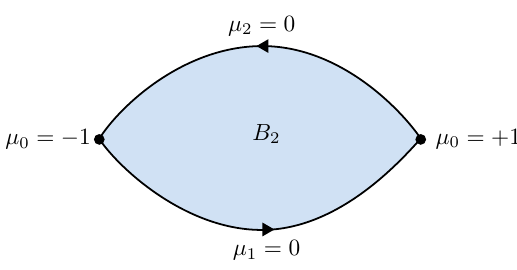
Figure 2 . Schematic depiction of the space B 2 described by the constrained coordinates (B.3) with line element dµ 2